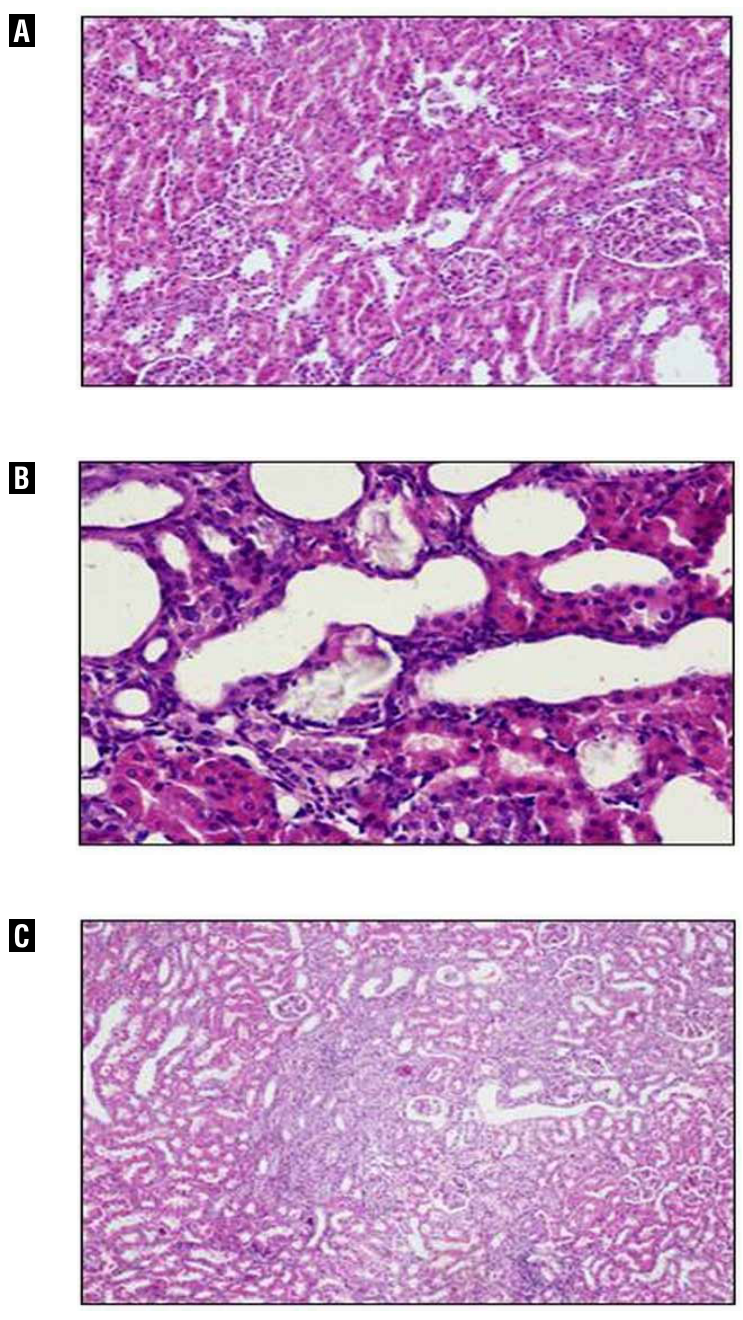
Figure 5 - Representative microscopic examination under light microscope of renal